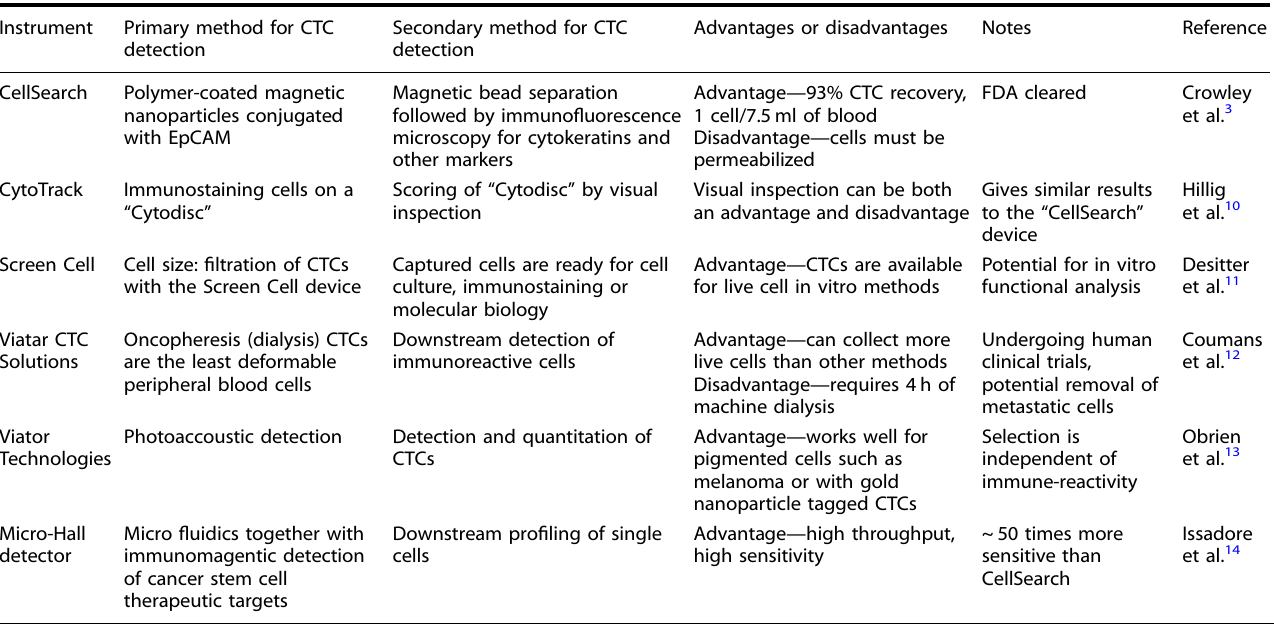
Table 1. Several examples of instruments in use for detection and analysis of